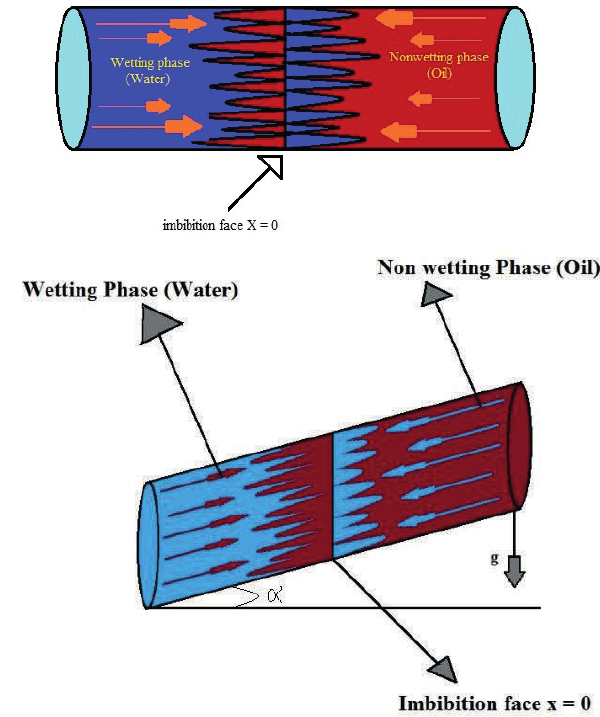
Fig. 1: schematic diagram of Imbibition